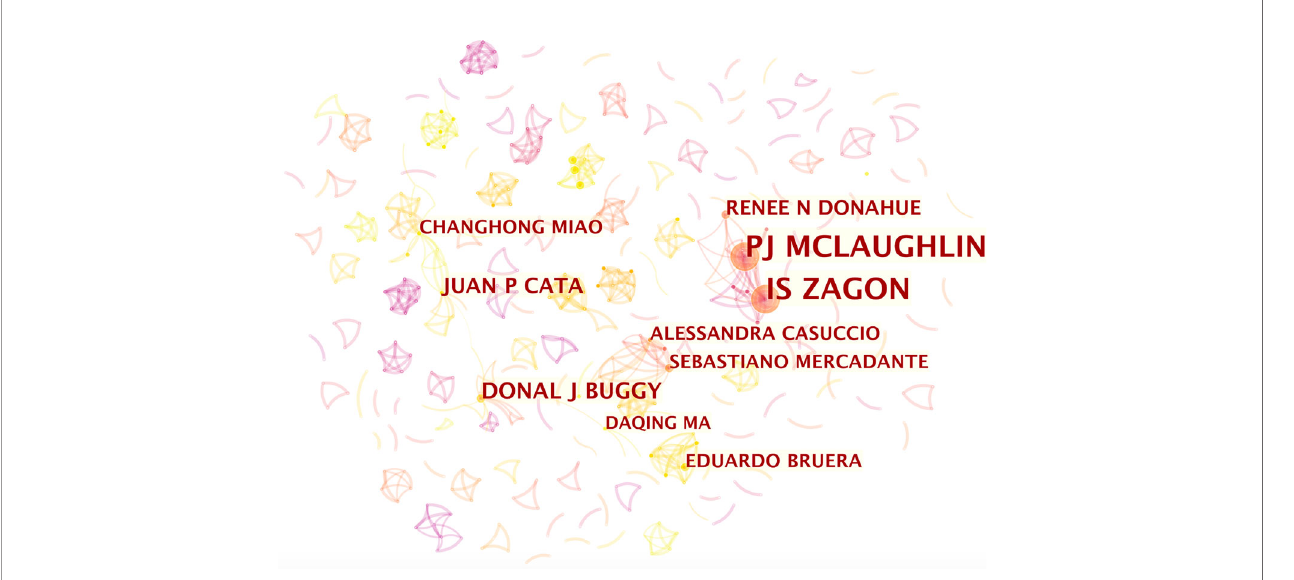
FIGURE 3 | Citespace network of co-authorship in the fi eld of anesthesia and cancer research. Each circle represents one author. Size of circle is positively correlated with the number of articles published by authors, and links between two circles represents a collaboration between two authors on the same article. Line thickness is positively correlated with frequency of collaborations. Top 10 authors with the most publications are shown. Timespan: 2001-2020; Slice length =